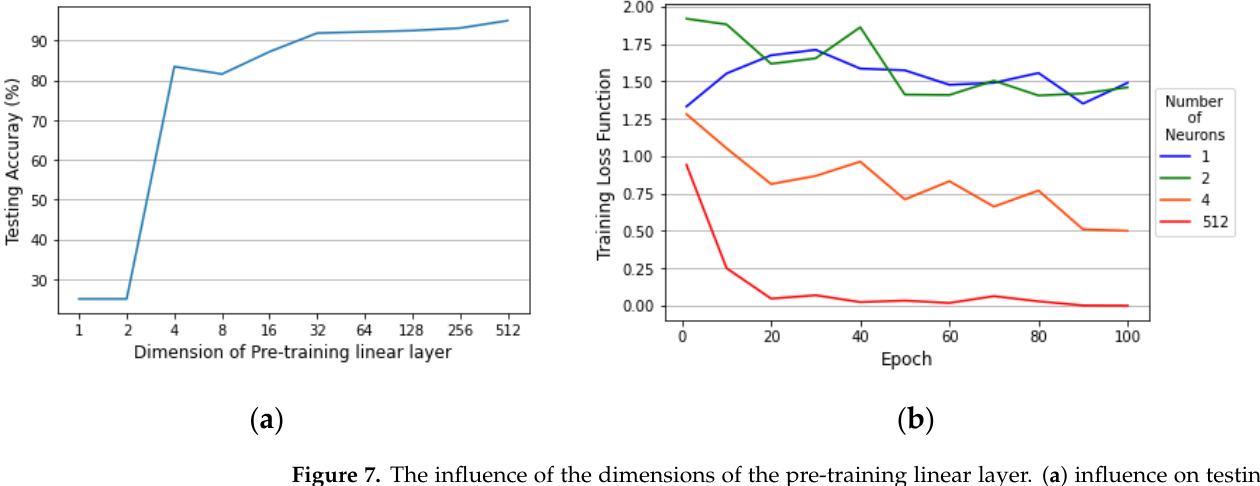
Figure 7. The influence of the dimensions of the pre-training linear layer. ( a ) influence on testing accuracy; ( b ) influence on training loss.